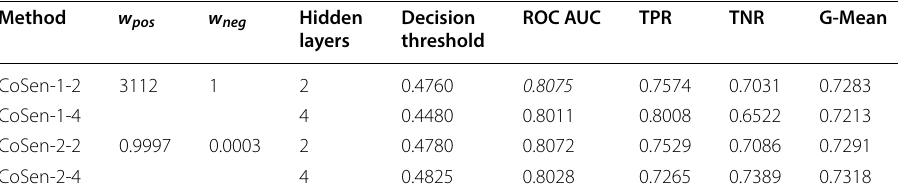
Table 16 Average cost-sensitive results (30 runs)